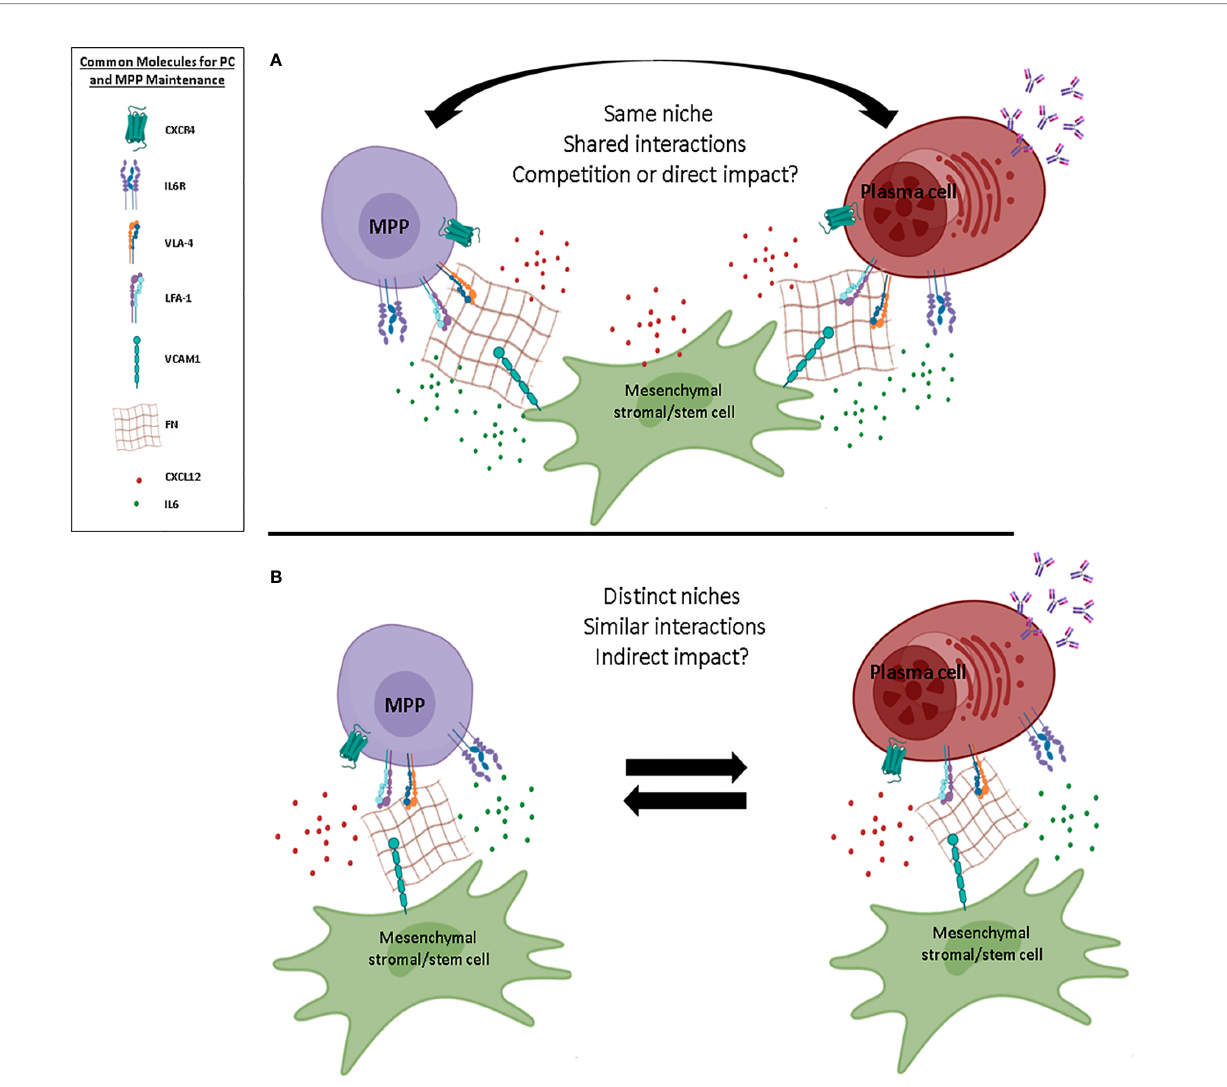
FIGURE 3 | Possible BM niche models for MPPs and PCs. Schematic representation of two different models of multipotent progenitor (MPP) and plasma cell (PC) niches within the BM. (A) In the fi rst model, MPPs and PCs share common niches and reciprocally impact their biology, maintenance, and fate. (B) In the second model, MPPs and PCs display distinct niches despite common ligand/receptor interactions, and potentially have an indirect impact on each other. Common molecules for PC and MPP maintenance within the BM are shown. FN, fi bronectin; IL, interleukin; ILR, interleukin receptor. Figure created using the BioRender icon